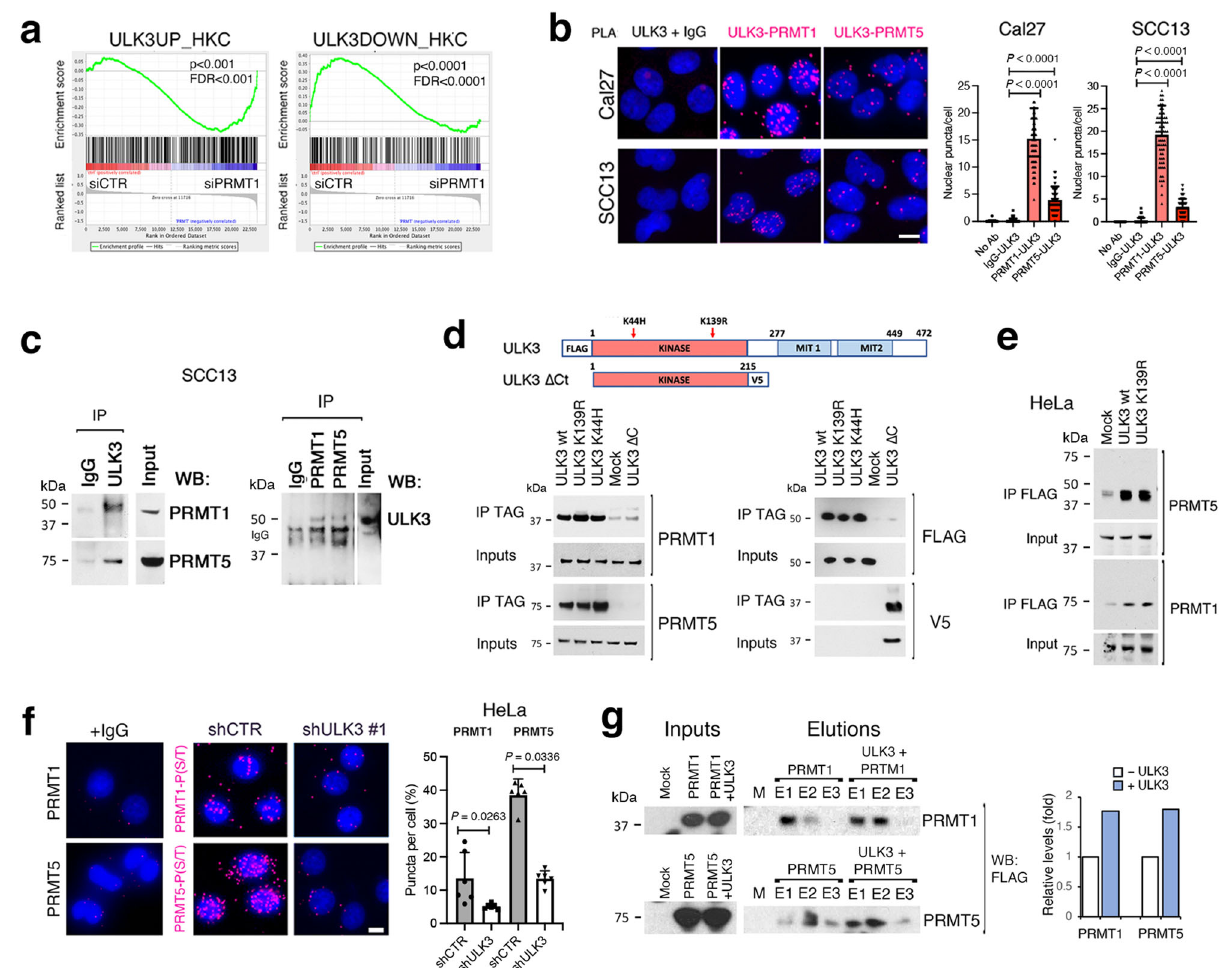
Fig. 6 | ULK3 associates with the arginine methylases PRMT1 and PRMT5. a GSEA of HKCs pro fi les with PRMT1 silencing by siRNA 36 versus up- or down- regulatedsignaturesfromHKCswith ULK3 silencing, P <0.001,permutation-based p.TheVenn diagram of genes modulated by ULK3silencing and bound byULK3in ChIP-seqinSCC13cellsisinSupplementaryFig.6a.Thelistofthegenesmodulated by siPRMT1 and shULK3 in HKCs is in Supplementary Fig. 6b. b Proximity ligation assays(PLA)oftwoSCCcelllineswithanti-ULK3and-PRMT1or-PRMT5antibodies, with anti-ULK3 alone or IgG as controls. Representative images and quanti fi cation of the magenta puncta from the juxtaposition of ULK3 and PRMT1 or PRMT5 antibodies, n (cells/condition)= 75, mean±SEM, P <0.01, two-tailed unpaired t-test. Scale bar 5 µ m. c Immunoprecipitations (IP) with anti -ULK3 (ULK3) or IgG antibodiesfromSCC13cellsfollowed byPRMT1and PRMT5immunoblotting(left), and IPs with anti -PRMT1, -PRMT5, or IgG antibodies followed by ULK3 immuno- blotting (right). Inputs were run on the same gel. d ULK3 protein map with indi- cated the kinase and the microtubule-interacting (MIT1/2) domains, the positions of inactivating mutations (K139R and K44H) 16,17 , C-terminus truncation ( Δ C) 18 and